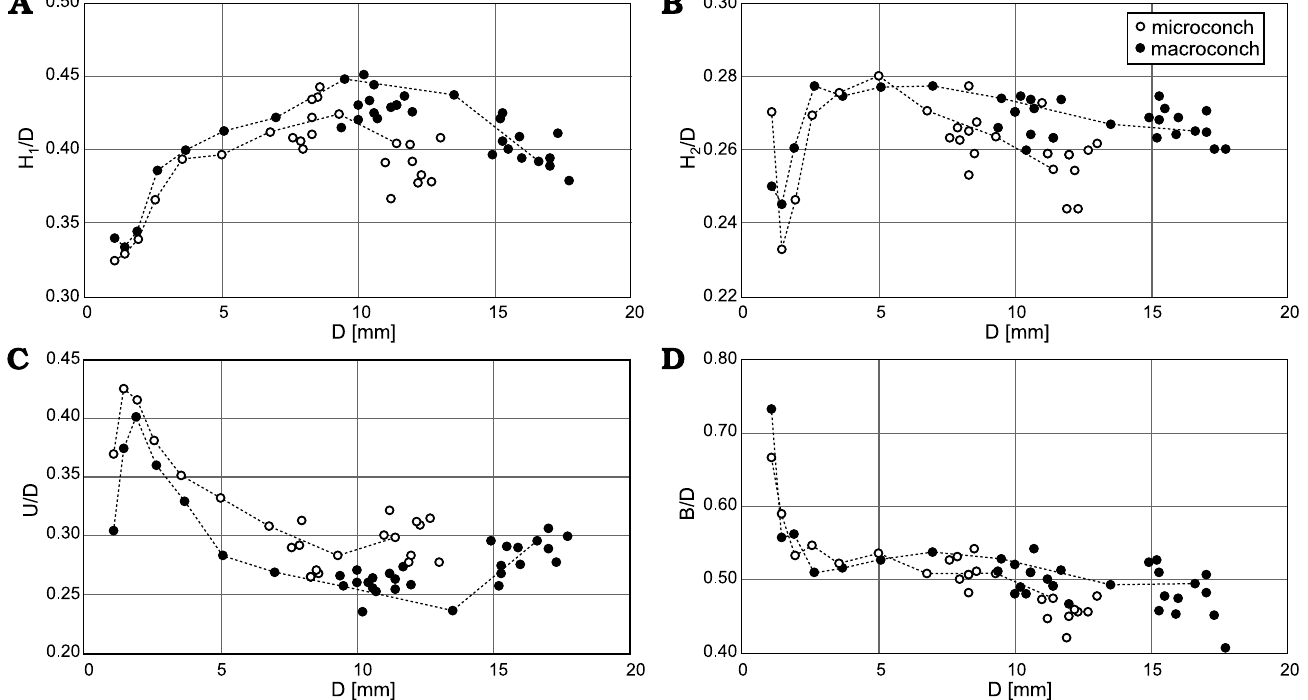
7. Scatter diagrams of four parameters versus shell diameter (D) of tetragonitid ammonoid Tetragonites minimus Shigeta, 1989, from the Santonian, Yezo Group in Hokkaido, Japan. A . H 1 /D (whorl height ratio). B . H 2 /D (ventral whorl height ratio). C . U/D (umbilical width ratio). D . B/D (whorl breadth ratio). Abbreviations: H 1 , whorl height; H 2 , ventral whorl height; U, umbilical width; B, whorl